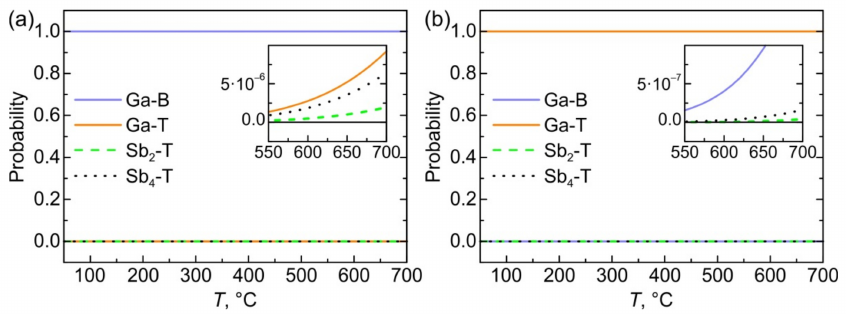
Figure 5. Probability of the oxygen ( a ) and fluorine ( b ) atom to be adsorbed in specific positions on the GaSb(111)A surface versus temperature. Inset graphs show the differences in probability given at higher